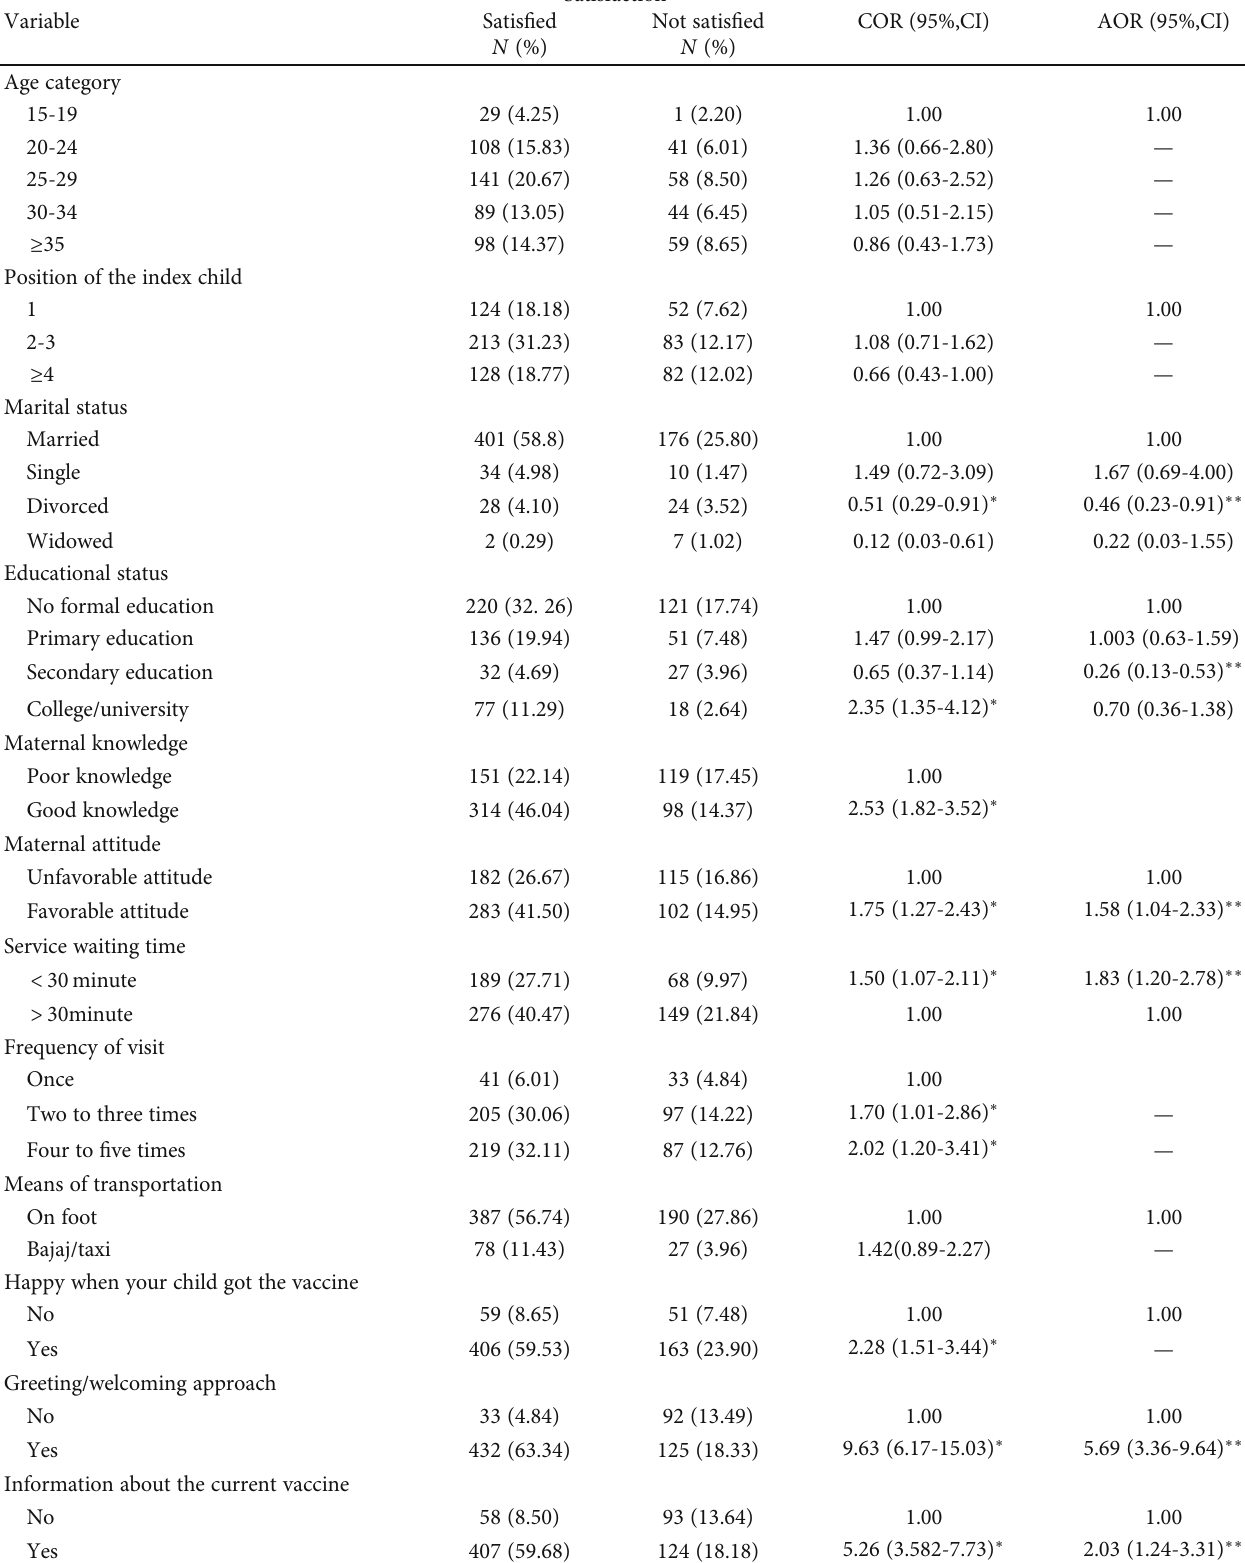
Table 5: Bivariable and multivariable logistic regression analyses for maternal satisfaction among clients whose children are